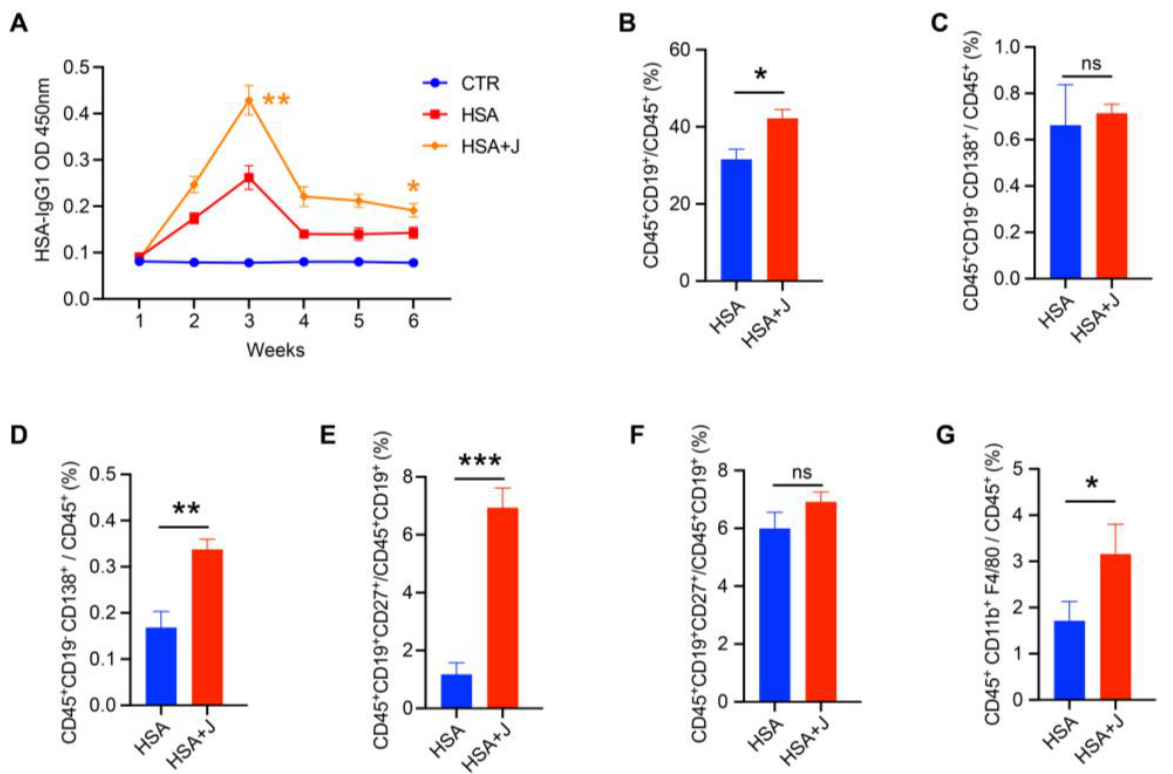
Figure 3. Administrating jujube powder a week in advance enhanced vaccine antibody and immune cell response in mice. ( A ) The concentration of HSA-specific IgG1 antibody in mice serum post- vaccine. ( B , C ) The proportions of B cells and plasma cells in the spleens of the HSA and HSA+J groups. ( D , E ) The proportions of plasma cells and memory B cells in the peripheral blood of the HSA and HSA+J groups. ( F ) The proportions of memory B cells in the spleens of the HSA and HSA+J groups. ( G ) The proportions of macrophages in the MLNs of the HSA and HSA+J groups. no signif- icance (ns) p > 0.05, * p < 0.05, ** p < 0.01, *** p < 0.001.